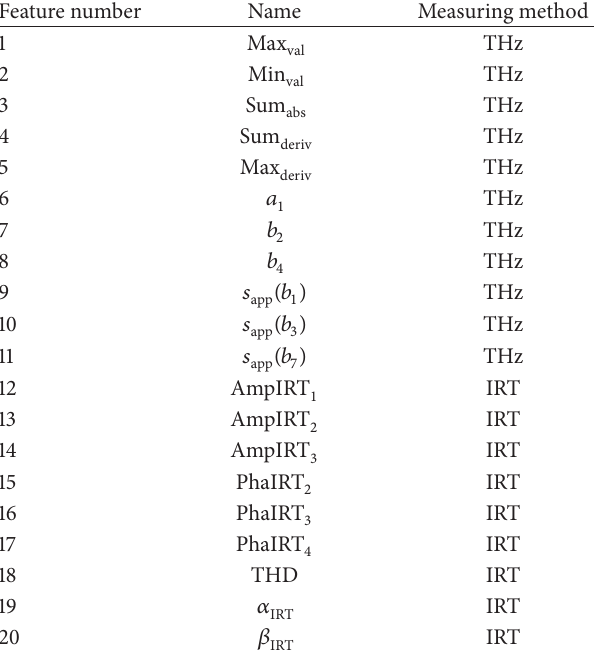
Table 2: Features’ vector 𝐹 of the